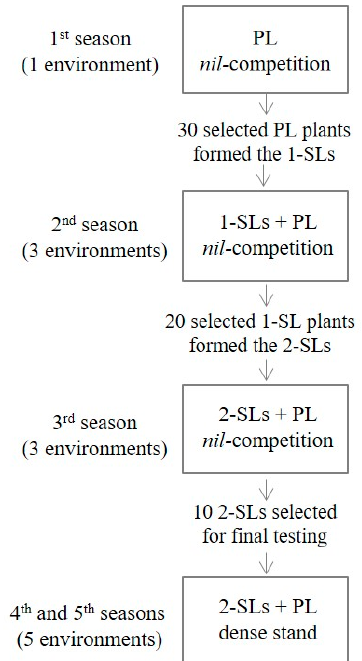
Figure 1. A line diagram of the breeding scheme including single-plant selection at the nil-competition regime within the parental landrace (PL) and the sister lines (SLs), with final SL evaluation at a dense stand (adapted from Vlachostergios et al. [28]). The seed material studied in the current work originated from one of the above final trials at a dense stand.